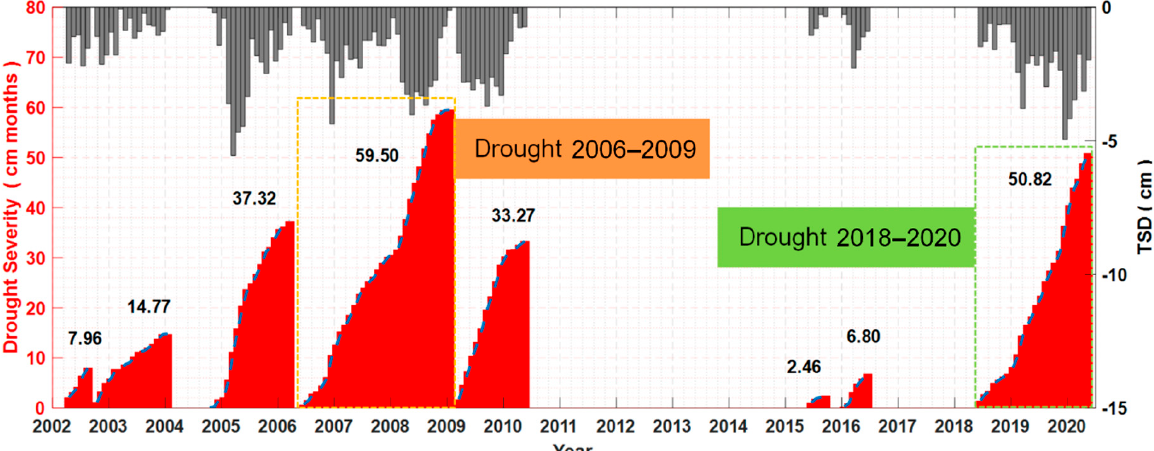
Figure 2. Durations and severities of drought periods over mainland Australia from April 2002 to May 2020 (The red bar: drought severity; the gray bar: total water storage deficit).